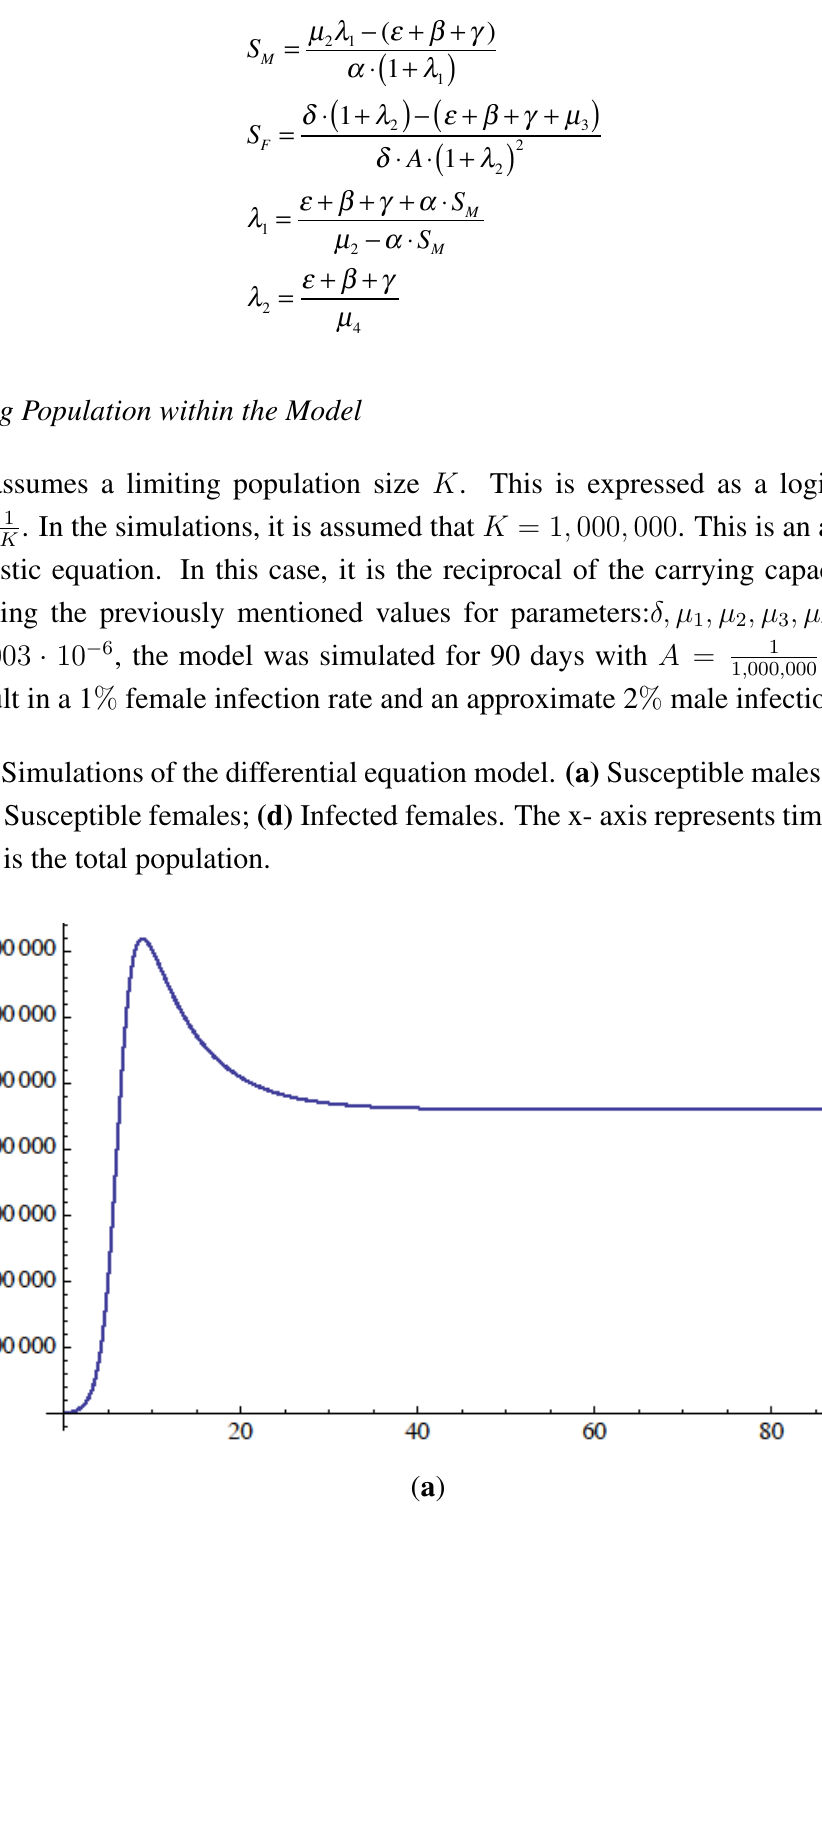
Figure 5. The values derived from the forced equilibrium.